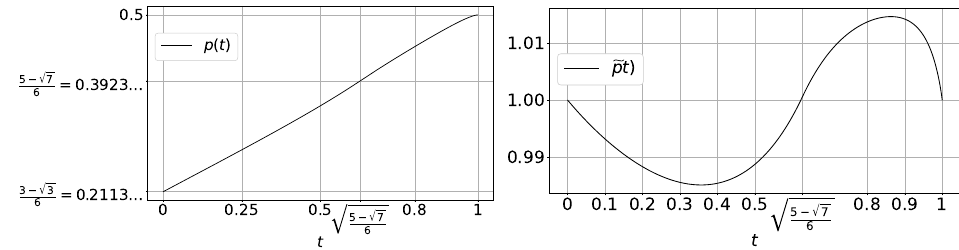
Figure 1. Plots of the functions p ( t ) and (cid:101) p ( t ) defined in (13) and (14), respectively. The next statement provides a simple upper bound for H ( t ) for small | t | in the form of a fractional-rational